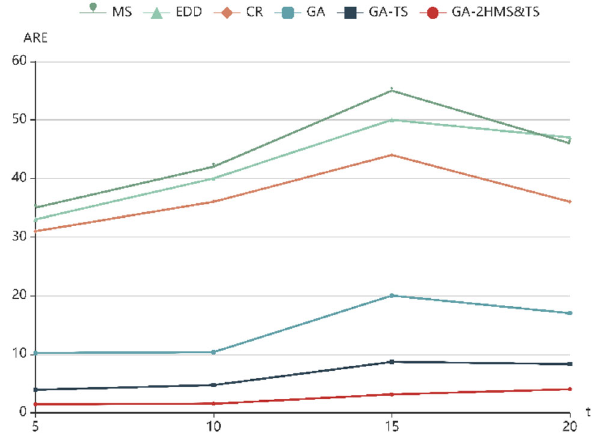
Fig. 6 ARE with different stages in a factory (t)